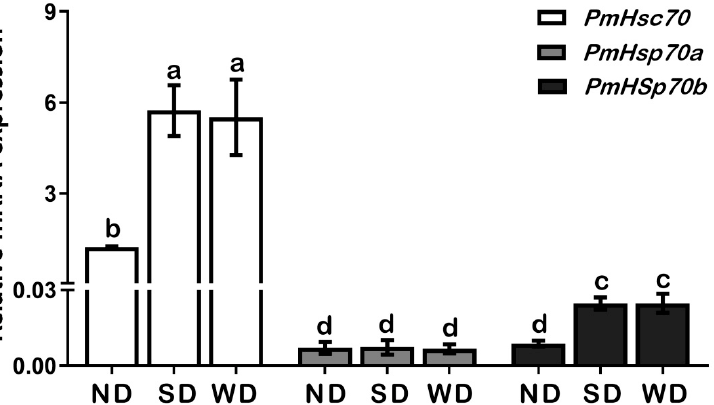
Figure 3. Relative mRNA levels of P mHsc70 , PmHsp70a , and PmHsp70b in ND, SD, and WD pupae of Pieris melete . The relative expression levels (Mean ± SE) are normalized to β -actin and 18S rRNA. Different letters above the bar indicate significant differences by ANOVA and post hoc Bonferroni multiple comparison test ( p < 0.05).